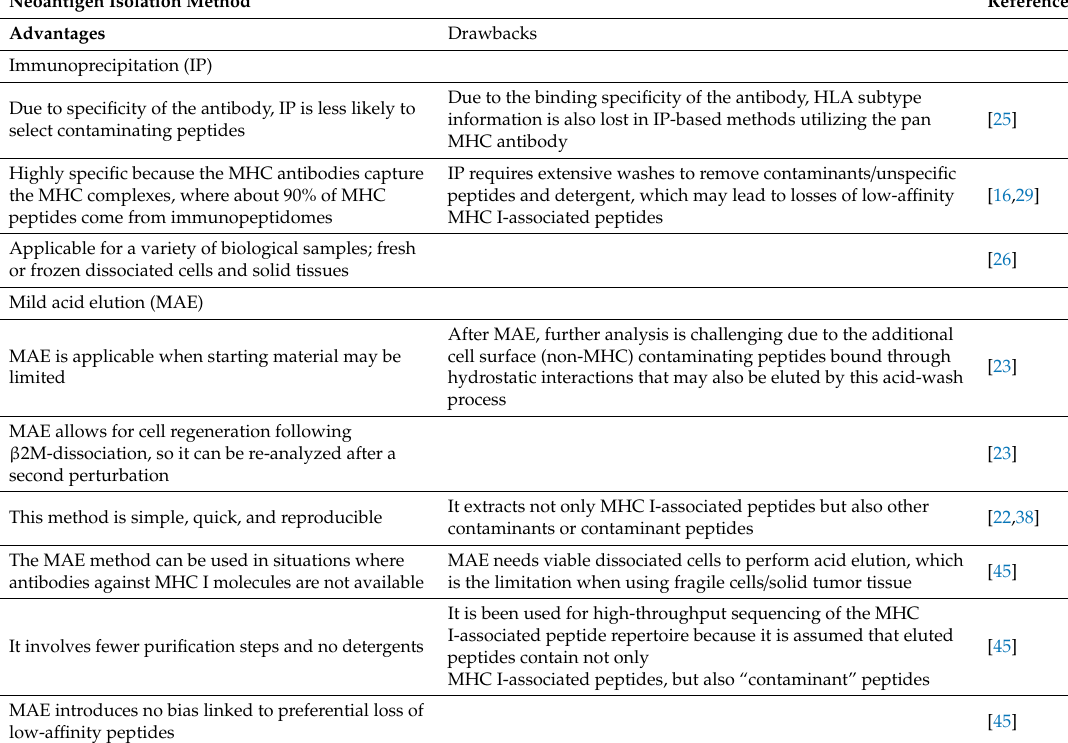
Comparison of advantages and drawbacks between mild acid elution (MAE)